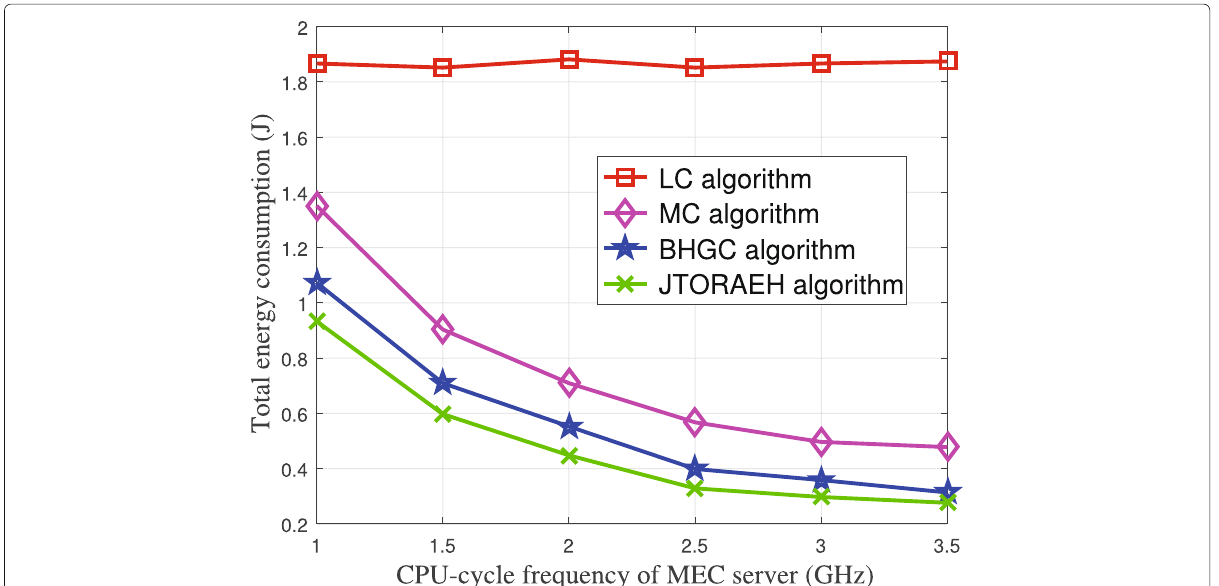
Fig. 5 Total energy consumption versus CPU-cycle frequency of MEC